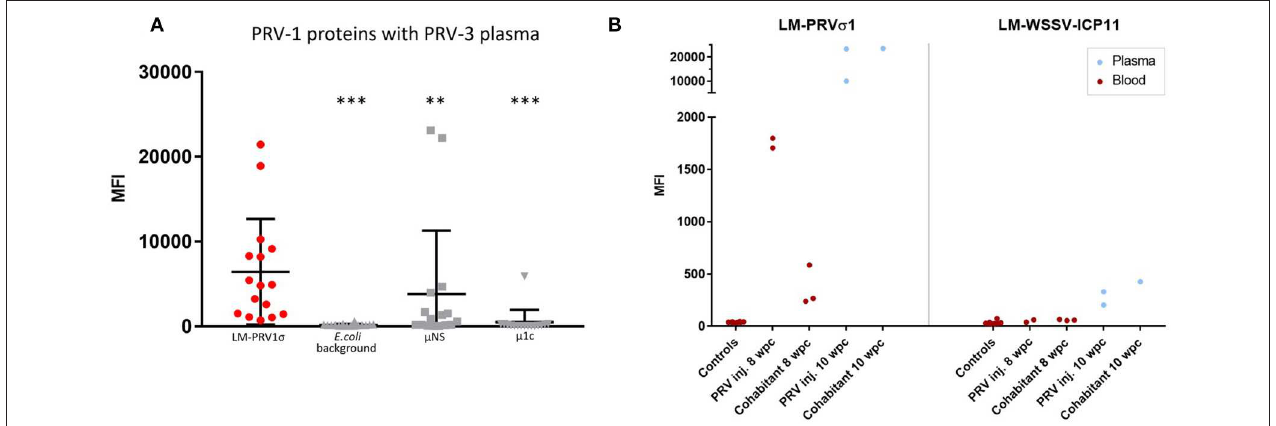
FIGURE 5 | Detection of cross-binding antibodies induced by PRV3 infection in rainbow trout. (A) Field samples from a PRV-3 outbreak in rainbow trout analyzed with LM-PRV σ 1, µ NS, and µ 1c (PRV-1) coupled beads in the immunoassay. Significant difference between MFI of LM-PRV σ 1 beads and the other beads are indicated by asterisks (Mann-Whitney test). (B) MFI from blood and plasma samples from individuals experimentally infected with PRV and uninfected controls using LM-PRV σ 1 and LM-WSSV-ICP11 coupled beads. All samples were